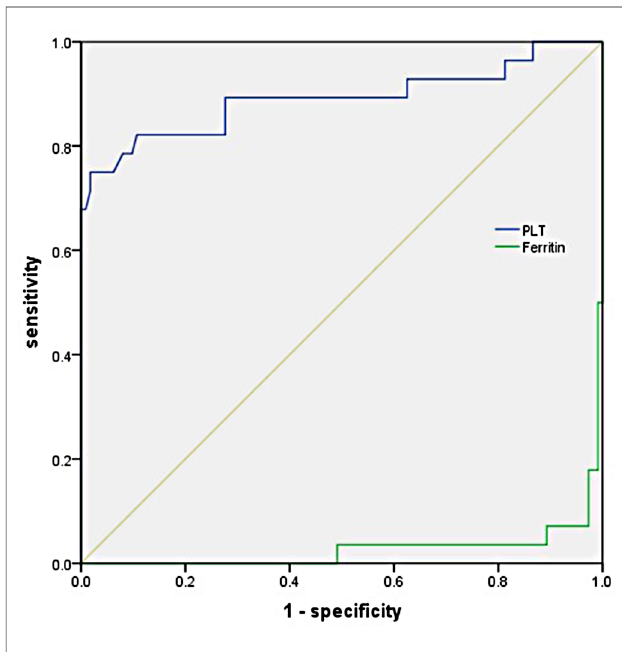
FIGURE 2 Receiver operating characteristic (ROC) curve analysis of PLT and serum ferritin in predicting the development of mas in children with